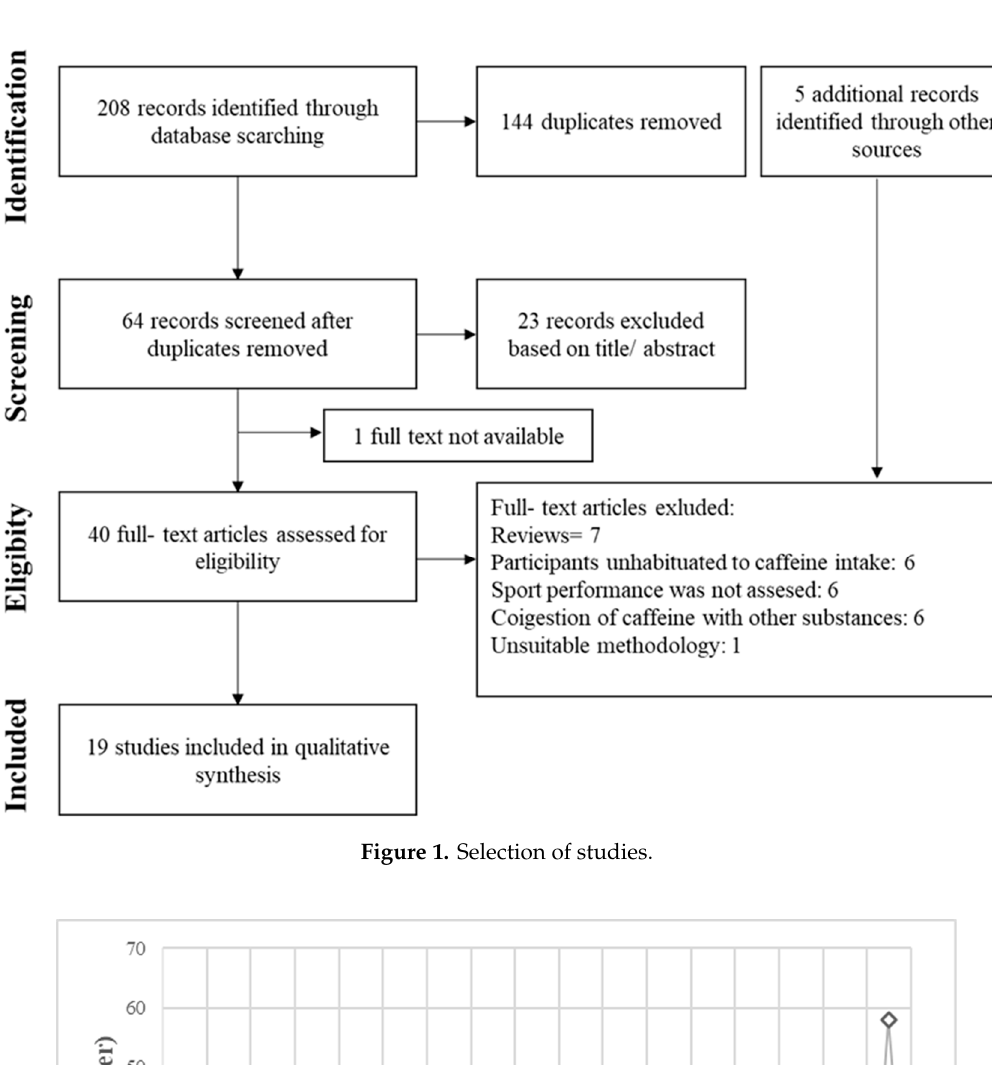
Figure 1. Selection of studies.